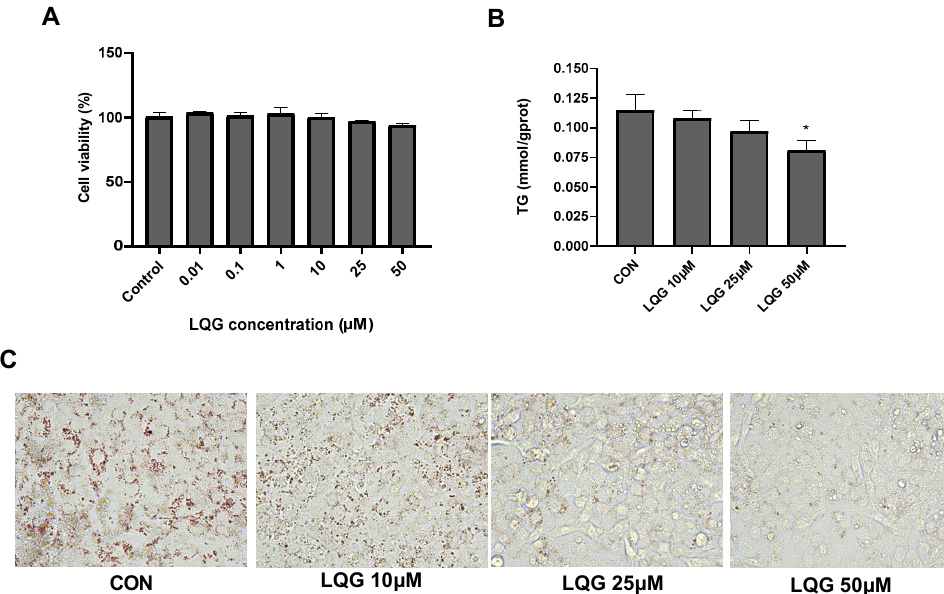
Figure 1. Effects of liquiritigenin (LQG) on cell viability and lipid accumulation in 3T3-L1 adipocytes. ( A ) 3T3-L1 cells were treated with different concentrations of LQG (0, 0.01, 0.1, 1, 10, 25, and 50 μ M) and cytotoxicity of the cells was expressed as optical density percentage. ( B ) LQG induced suppression of intracellular triglyceride (TG) levels in 3T3-L1 cells. TG levels of LQG at 10, 25, and 50 μ M were assayed and are expressed in bar charts. ( C ) Mature 3T3-L1 adipocytes treated with 10, 25, and 50 μ M LQG were stained with Oil Red O to observe lipid droplets at 400× magnification. Data are presented as means ± SEMs and analyzed with one-way ANOVA ( n = 3). * marks significant differences compared with control group ( p ≤ 0.05).